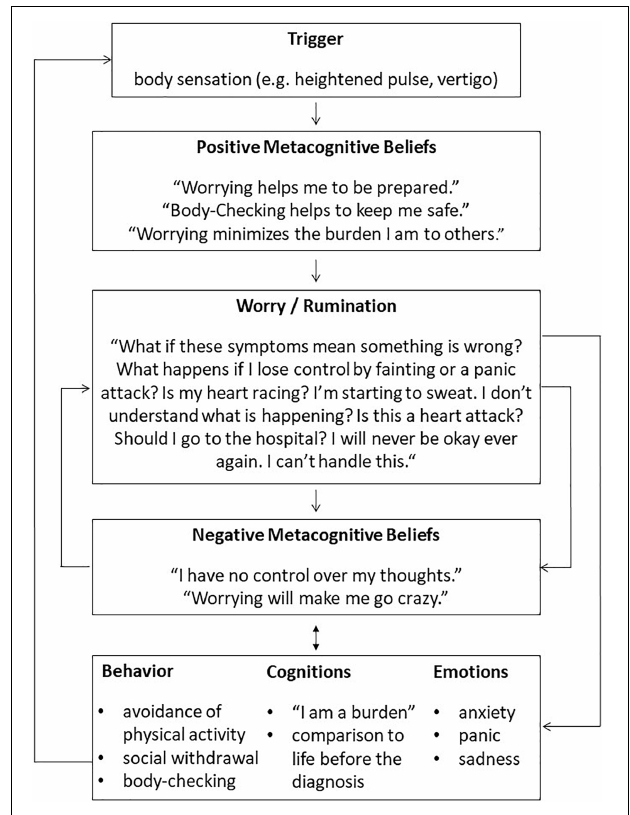
FIGURE 1 | Exemplary case formulation for a patient with idiopathic pulmonary arterial hypertension based on Wells